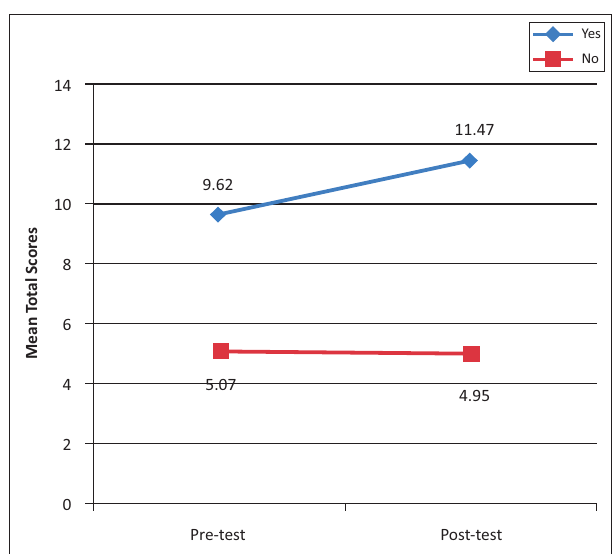
FIGURE 4: Pre-test and post-test scores for participants who had exposure/no exposure to